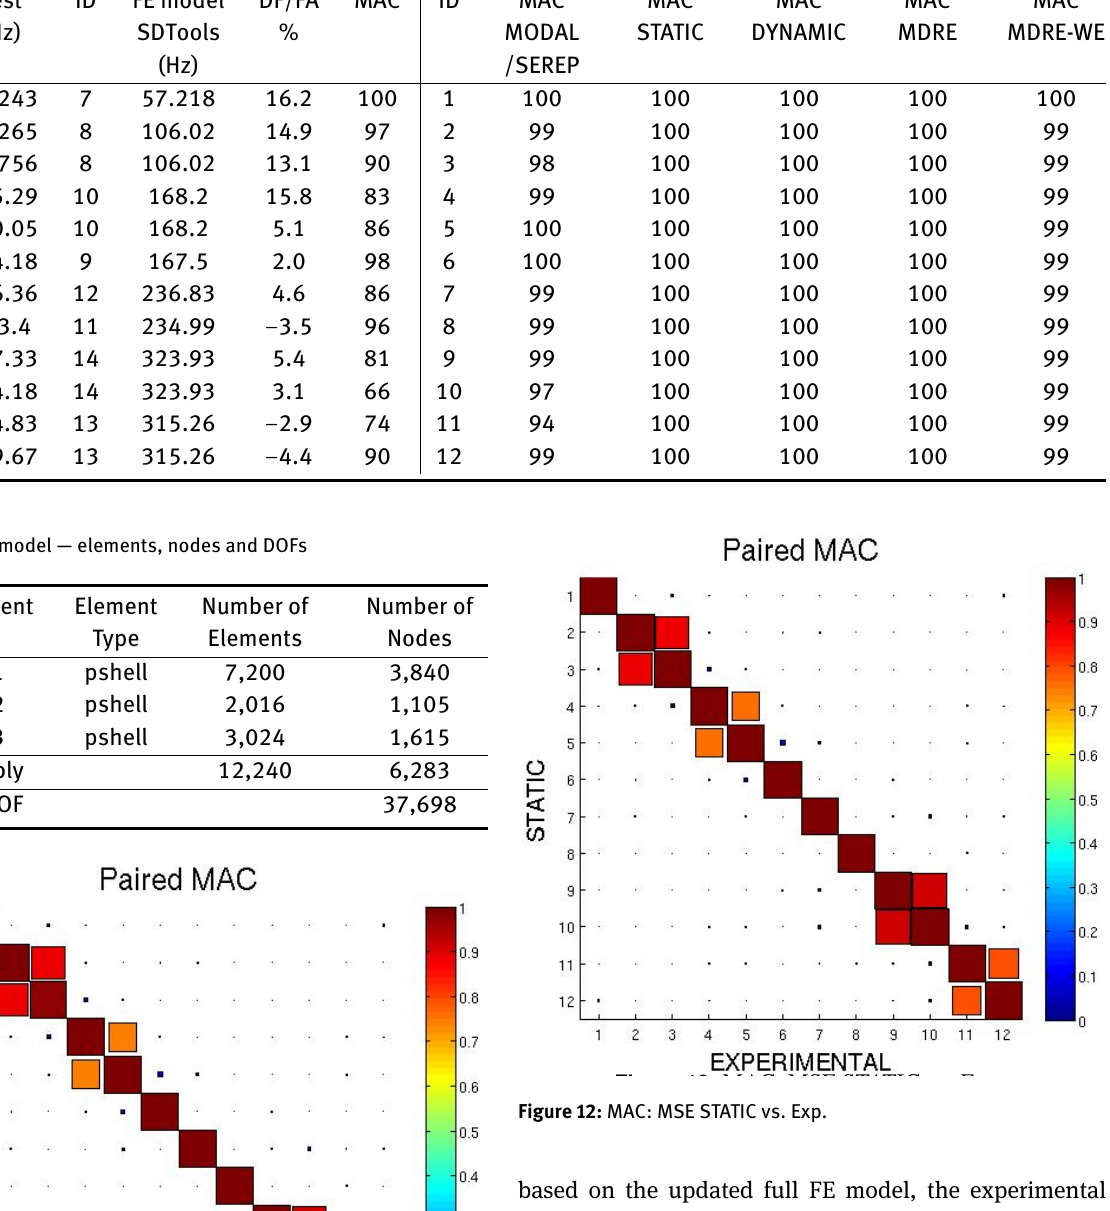
based on the updated full FE model, the experimental measurements and curve-fitting according the method- ology implemented in [29] using fe_exp command, (see Figures 11-15). The same number of paired modes are cal- culated (12 pairs) for all the MSE methods. An error of 0.1 is used in the interpolation of the MDRE-WE. In Figures 11-15, an improvement of the double correlation is iden- tified using the MSE methods versus the experimental Figure 11: MAC: MSE MODAL/SEREP vs. Exp. measurements. . The same number of DOF are obtained applying the MSE interpolation based on MOR methods according the number of DOF defined in the full model (37,698 DOF).